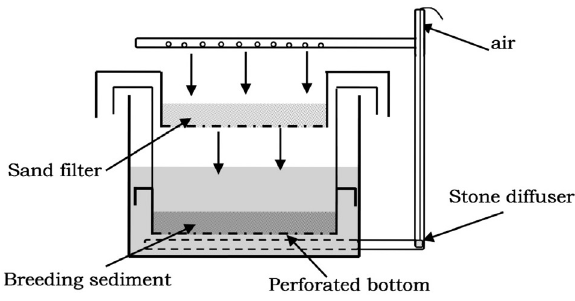
Fig. 1. – Schematic aquarium design used in the